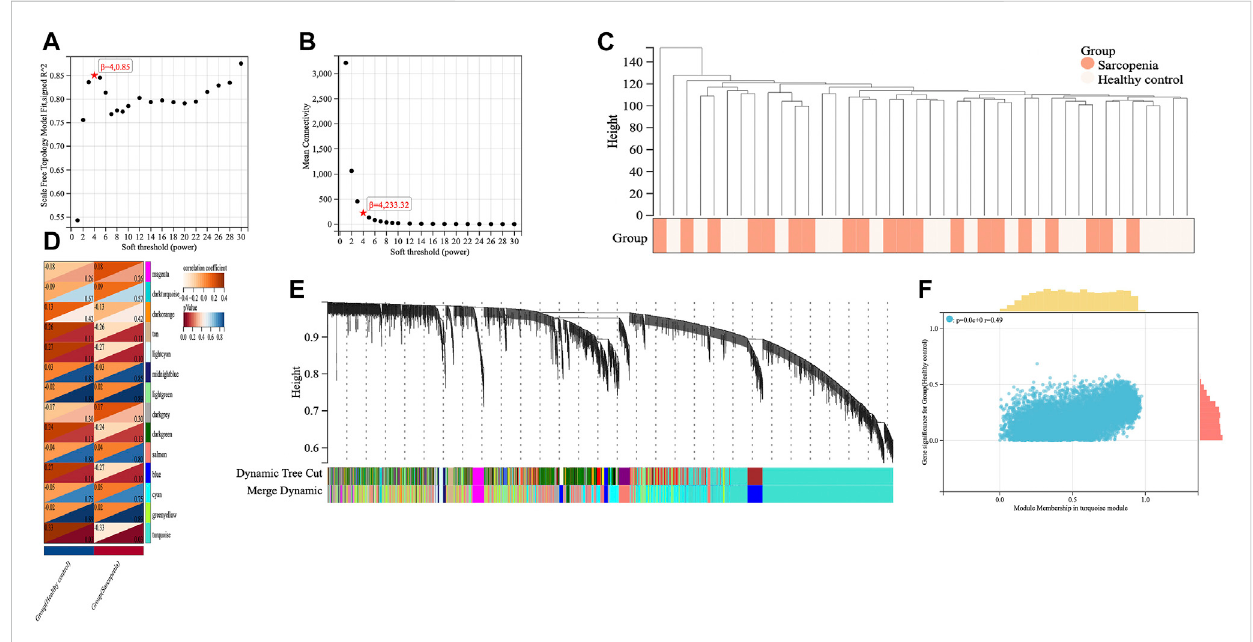
FIGURE 3 Screening of key genes by weighted gene co-expression network analysis (WGCNA). The scale independence (A) and the mean connectivity (B) to identify the soft threshold with best performance. (C) Clustering dendrogram and trait heatmap of samples. (D) The heatmap displaying the correlation between gene modulesand clinical traits. The rows represent gene modules and columns correspond to clinical traits. Each cell contains thecorrelation coef fi cient (upper number) and p value (lower number). (E) Hierarchical cluster dendrogram and color-coding of gene co-expression modules. (F) Scatter plot showing the relationship between gene signi fi cance and module membership in the turquoise